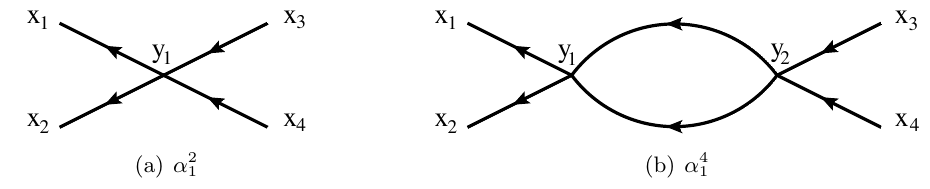
(cid:30) y ] to the four-point 1 1